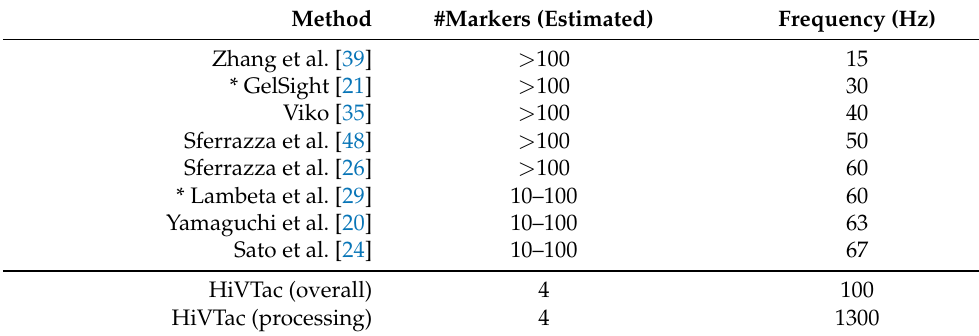
Table 1. Operating frequency of vision-based tactile sensors tracking markers.